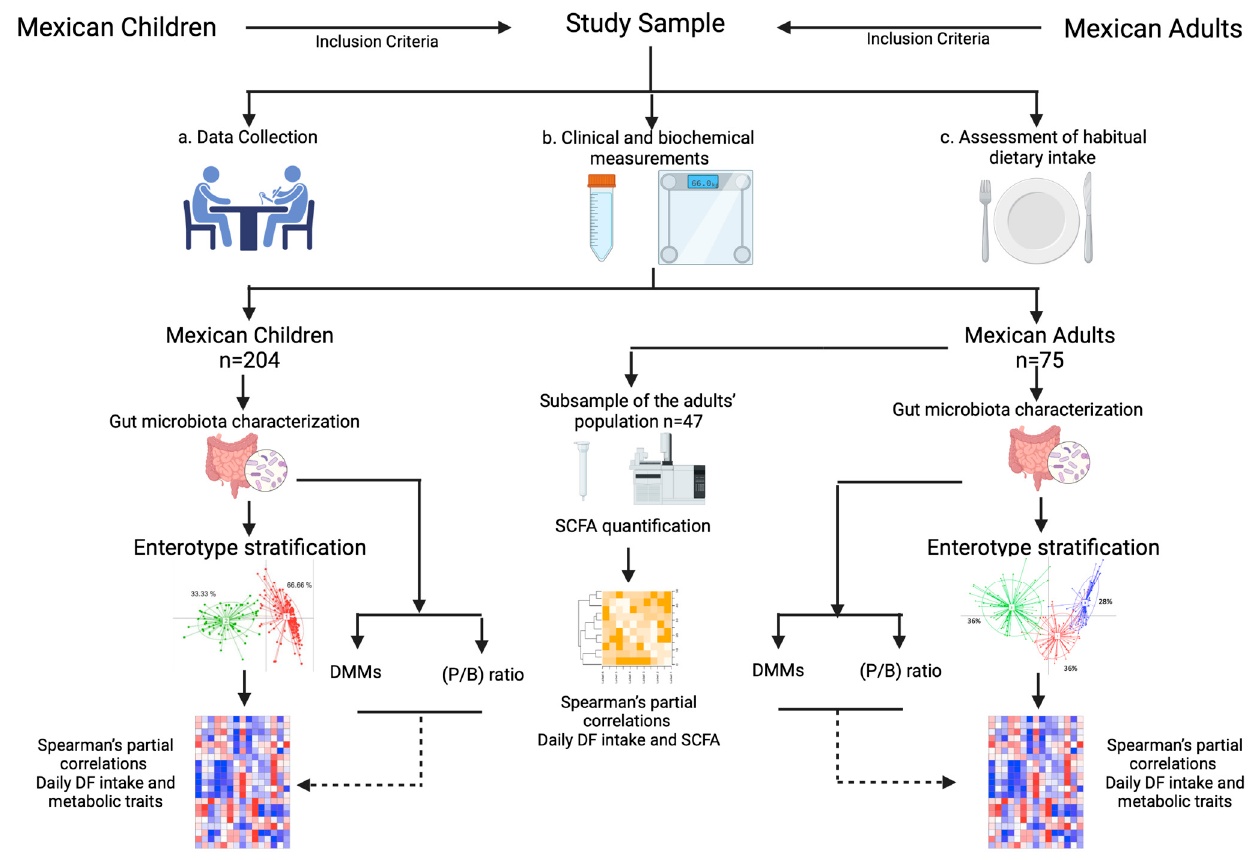
Figure 1. Overview of the workflow for recruitment, data acquisition and analysis. SCFA: Short-chain fatty acids, DMM: Dirichlet multinomial mixture models, P/B: Prevotella/Bacteroides . Created with Biorender.com.